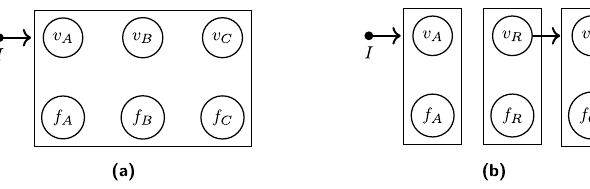
Figure A3: Equilibrium causal ordering graphs for the IFFLP network. ( a ) Modelled by equations ( A15 ) , ( A16 ) , and ( A17 ) and variables X X X , , A B C ; ( b ) modelled by equations ( A18 ) , ( A19 ) , and ( A20 ) and variables X X X , , A R C